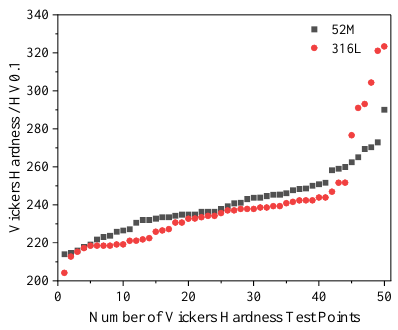
Figure 4. Vickers hardness data point diagram.